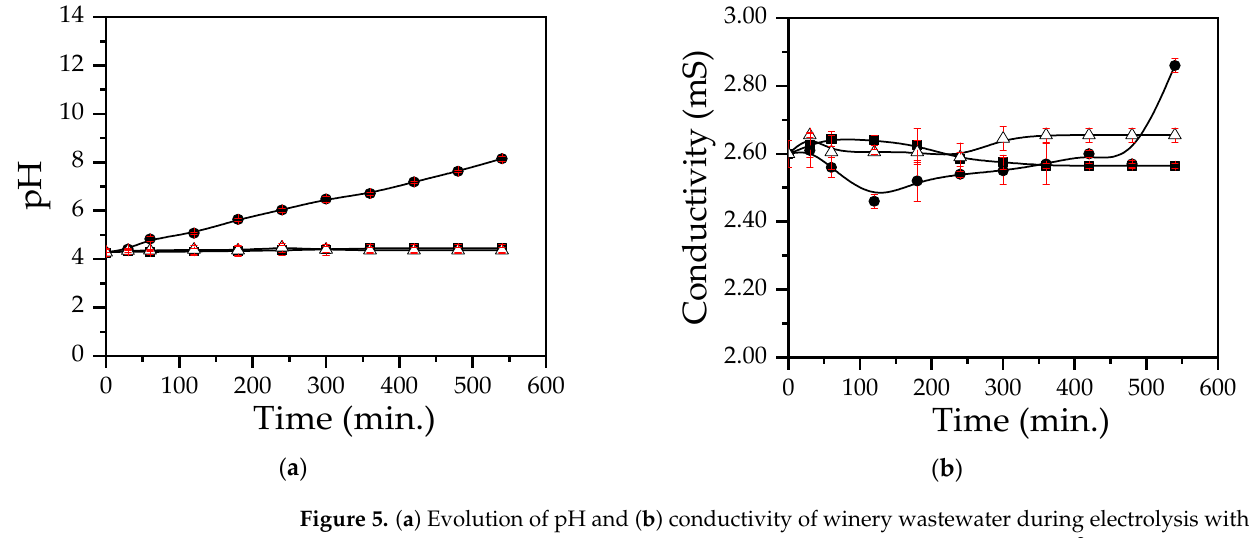
Figure 5. ( a ) Evolution of pH and ( b ) conductivity of winery wastewater during electrolysis without the addition of electrolyte support at 25 °C and pH 4.28 applying 30 mA/cm 2 . ( ■ ) MMO-Cl 2 , ( ∆ ) MMO-O 2 , ( ● ) BDD. Samples tested: